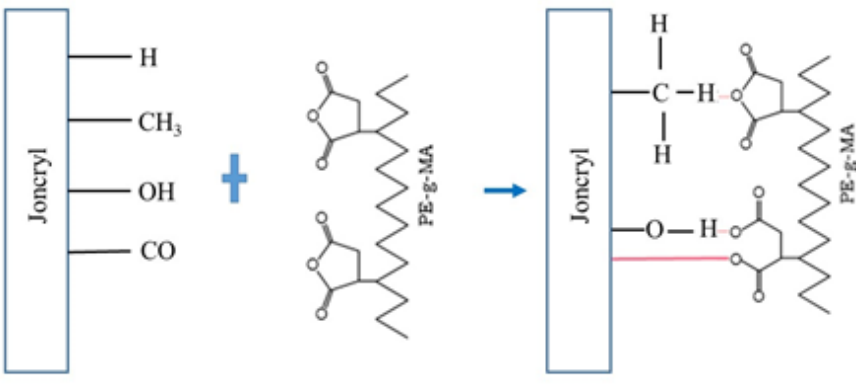
Figure 4. Schematic representation of a possible reaction between Joncryl and PE ‐ g ‐ MA. Degradation and Recuperation during